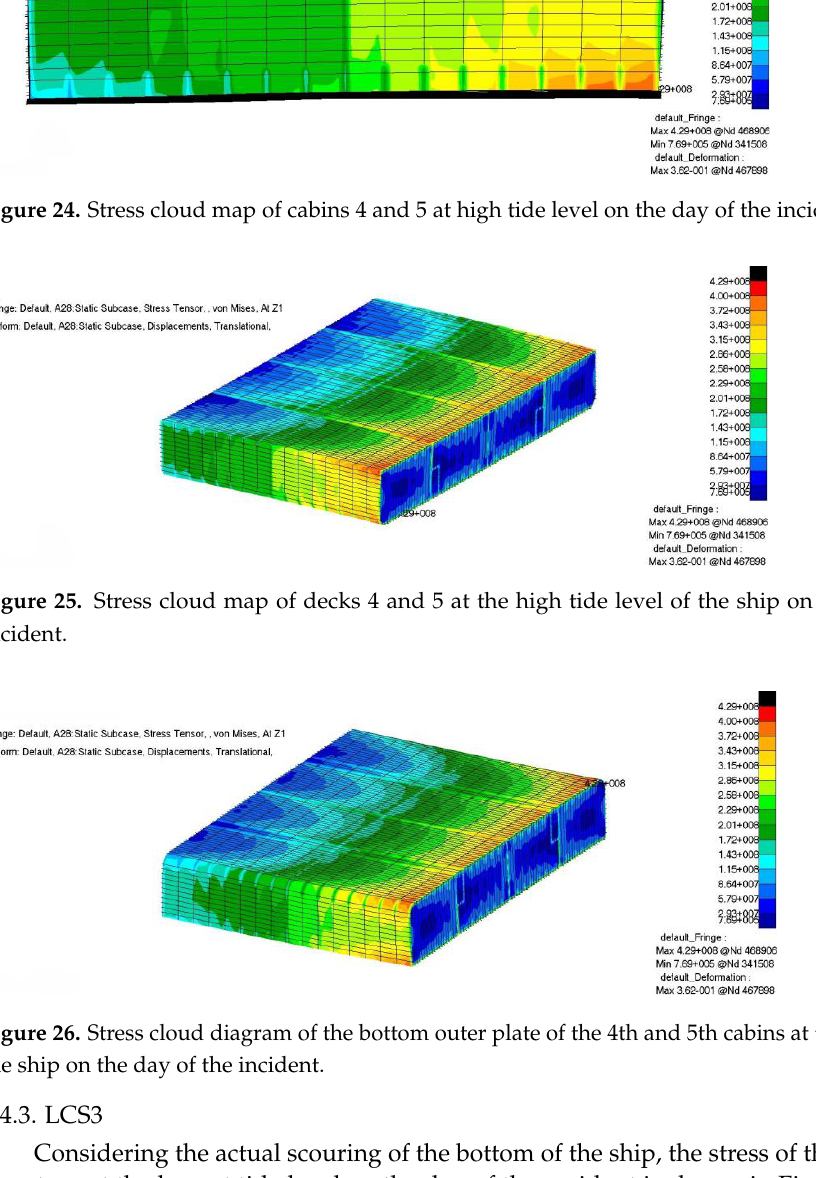
Figure 23. Stress cloud map of the ship at high tide level on the day of the incident.